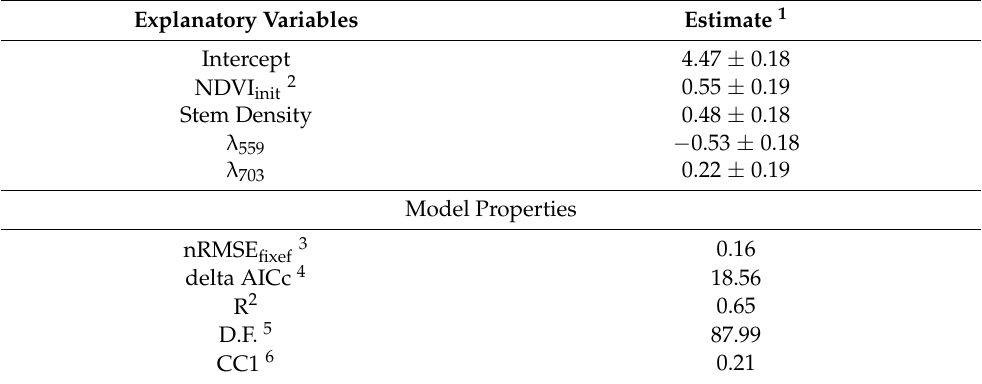
Table 6. Estimated coefficients for explanatory variables of marketable yield and the estimated spatial autocorrelation